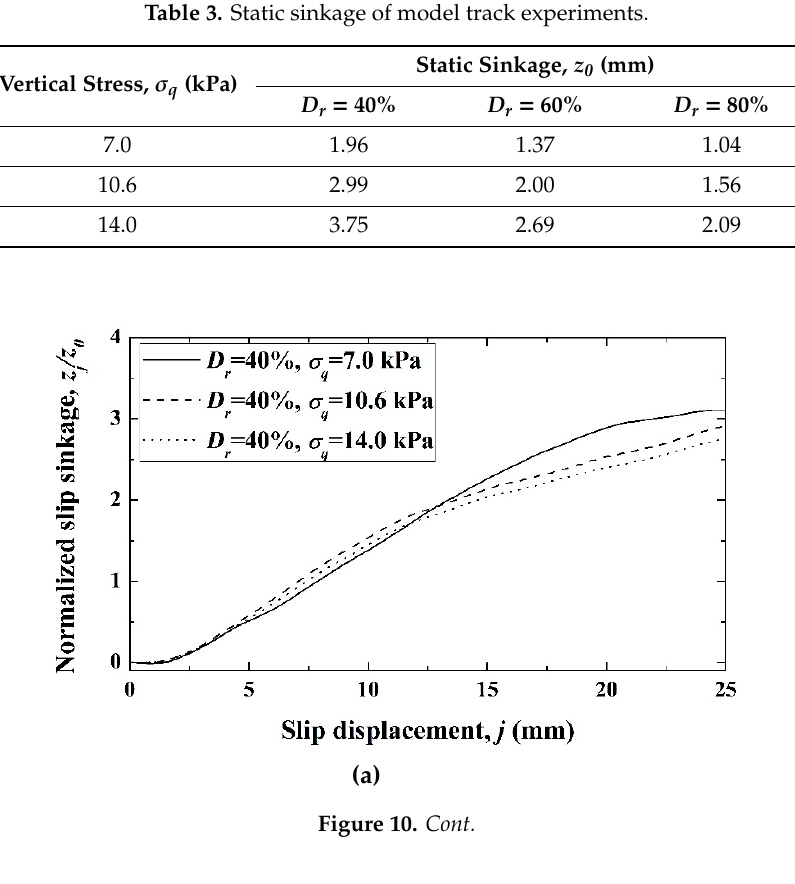
Table 3. Static sinkage of model track